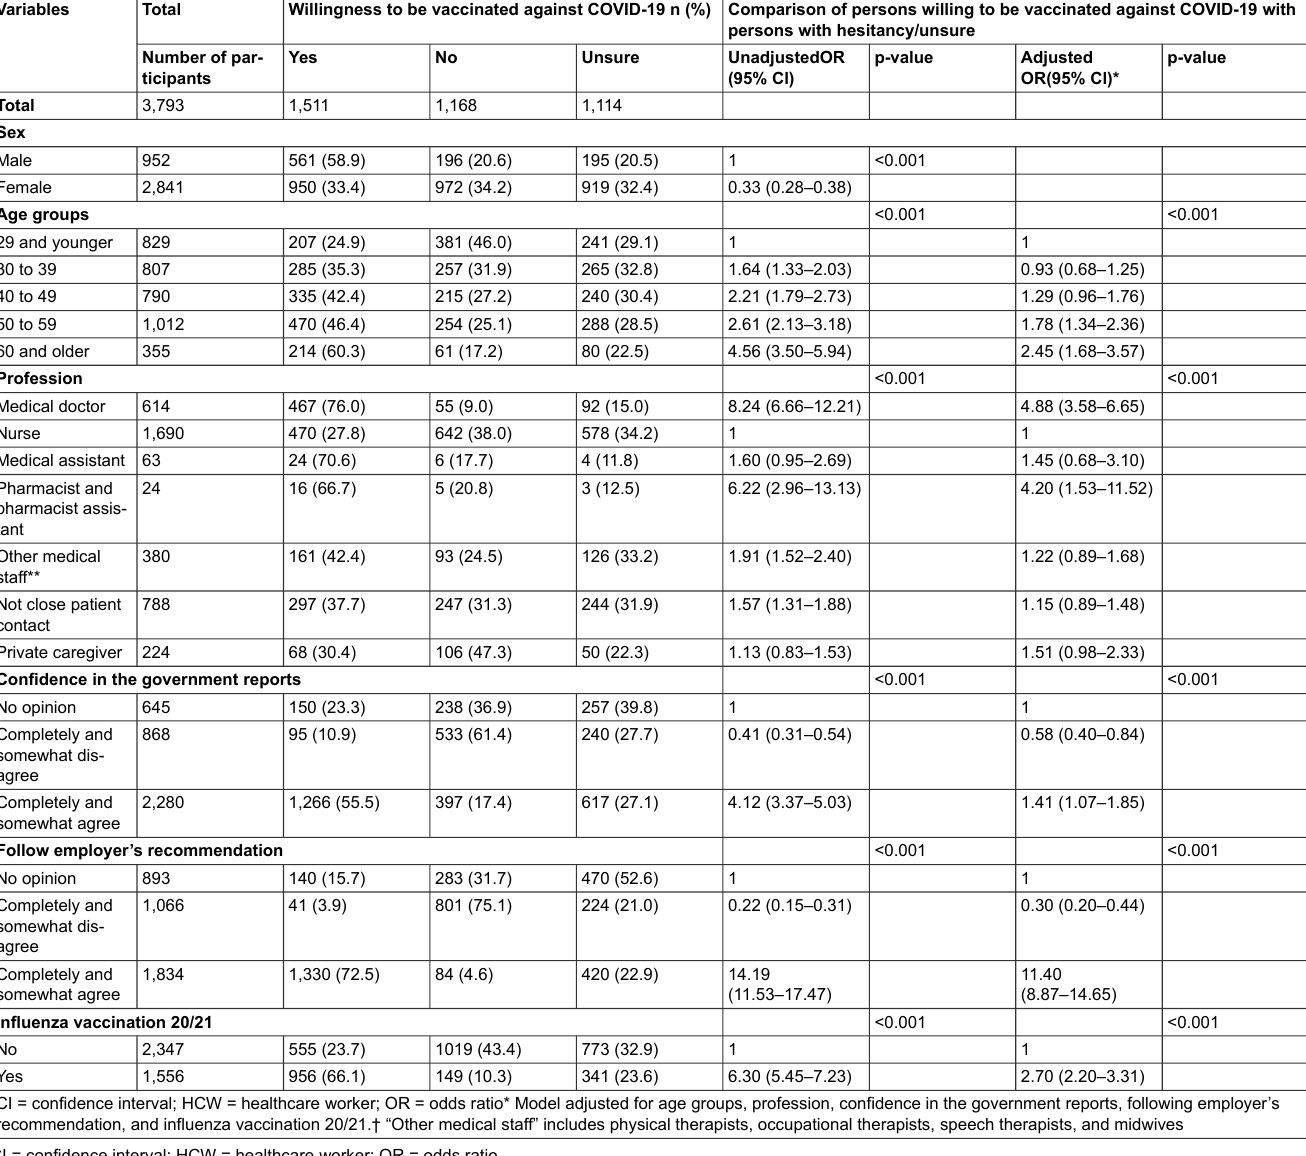
Table 2: Characteristics of healthcare workers’ willingness to be vaccinated against COVID-19, vaccine hesitancy and uncertainty about vaccination, and factors associated with willing- ness to be vaccinated.